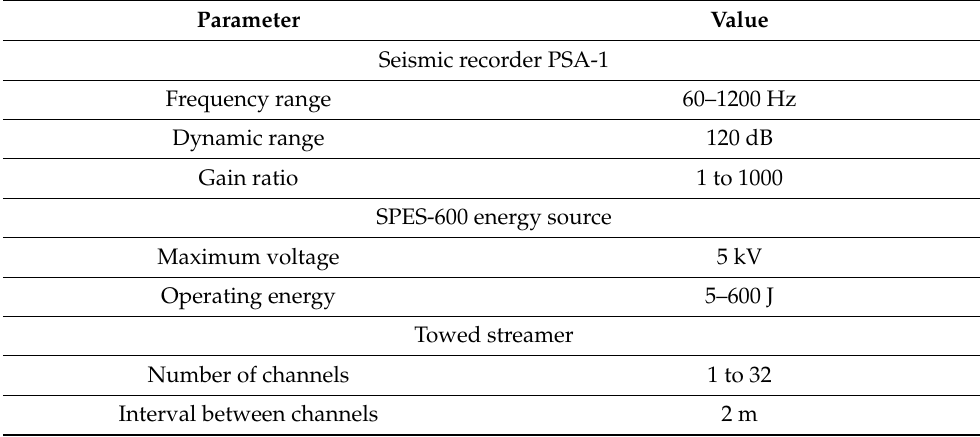
Figure 5. Components of the CSP system Geont-Shelf: energy source ( a ), seismic recorder ( b ), and towed streamer with sparker ( c ). Table 4. Main technical characteristics of the continuous seismic profiling